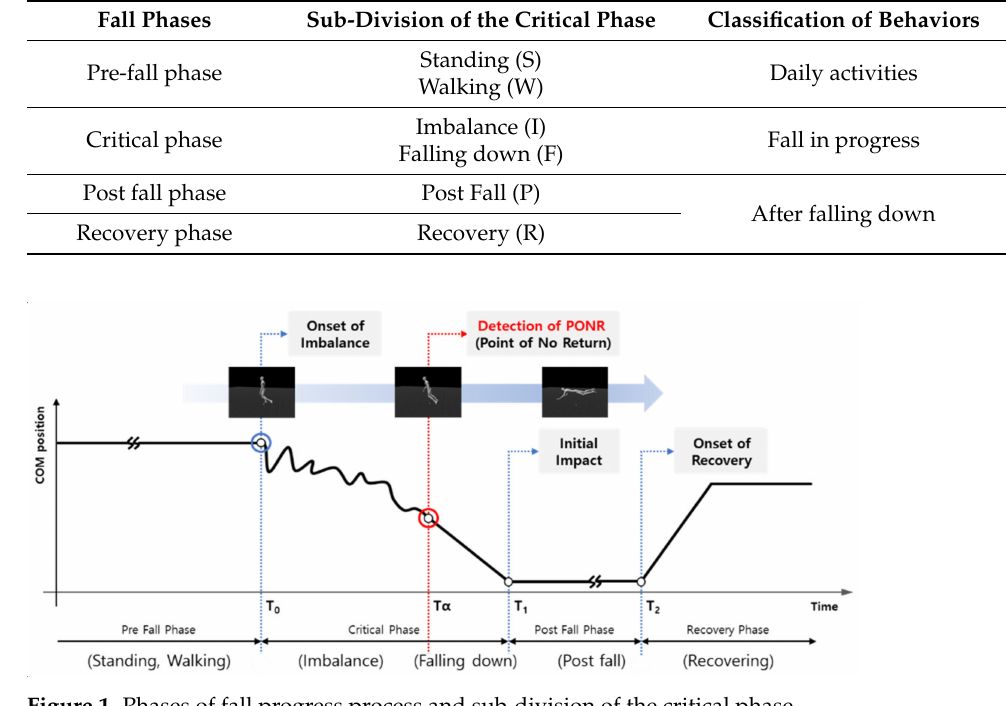
Figure 1. Phases of fall progress process and sub-division of the critical